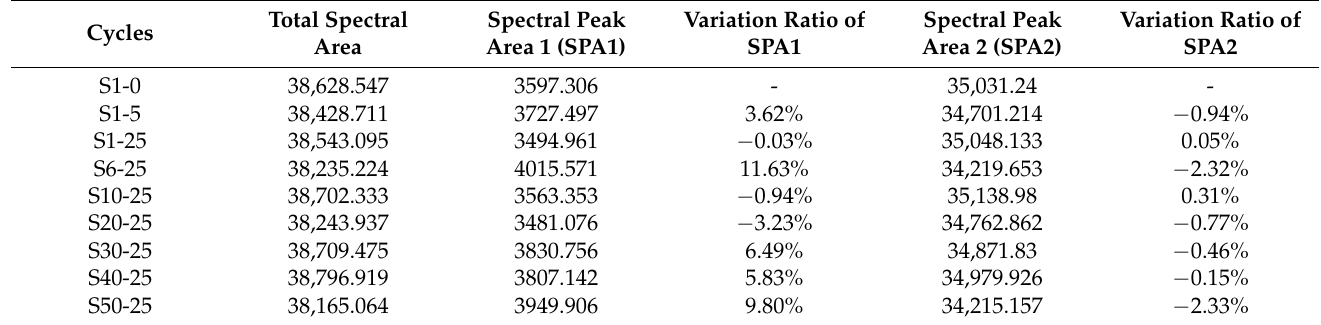
Table 4. Spectral peak area of NMR test in sandstone under alternating pore pressures.